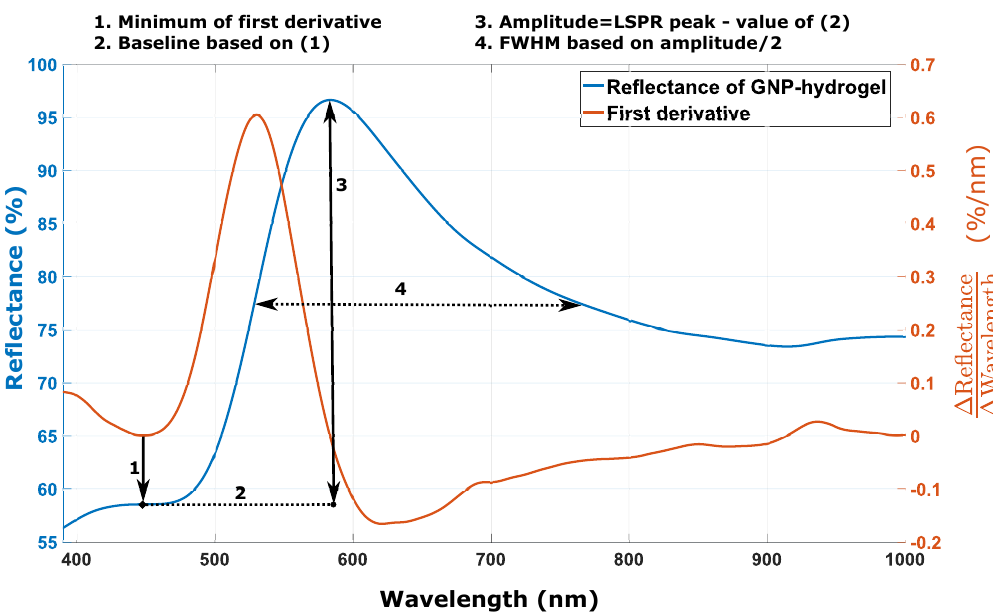
Figure 13. Smoothing fitted function of the reflectance of GNP-hydrogel with ND 03 at 1.7 × 10 11 particles/mL at pH 4.4 with the corresponding first derivative. The minimum of the first derivative of the reflectance of GNP-hydrogel determines the baseline used for computing the